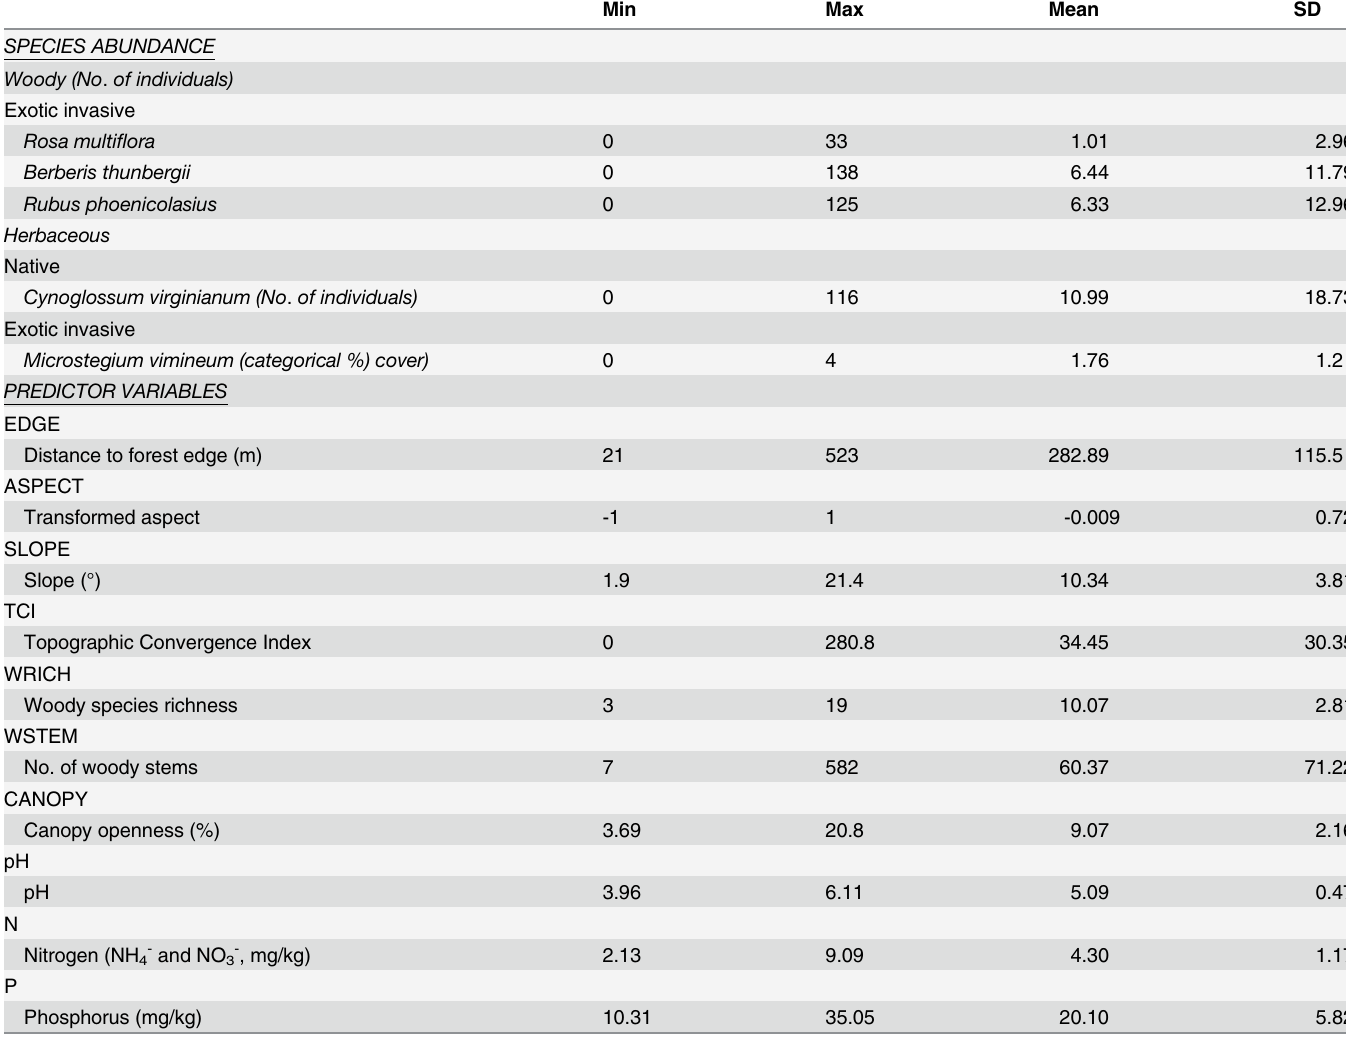
Table 1. The abundance measures (as per quadrat) of the five study species and the variables included in the generalized linear models.